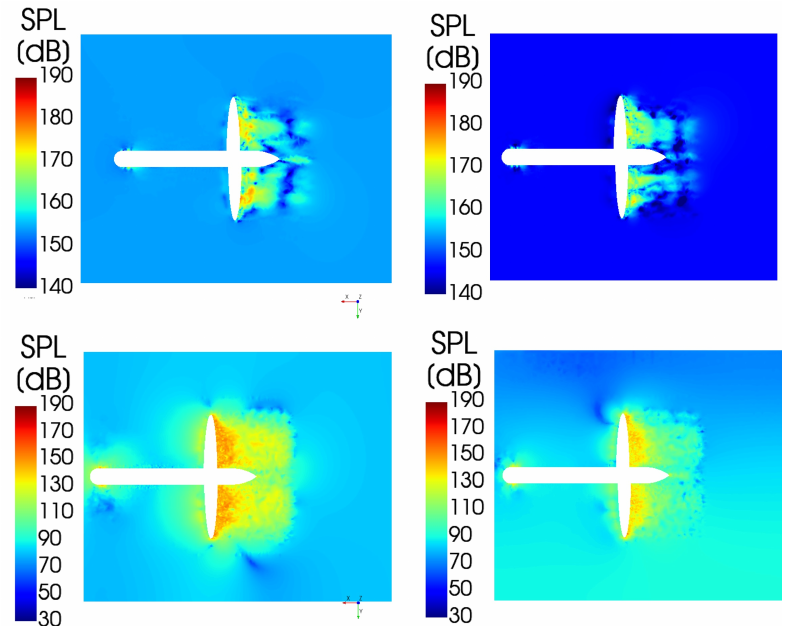
Figure 28. Sound pressure level contours in cavitation tunnel at 80 Hz ( top left ), 125 Hz ( top right ), 700 Hz ( bottom left ), and 1300 Hz ( bottom right )—VOF solution.